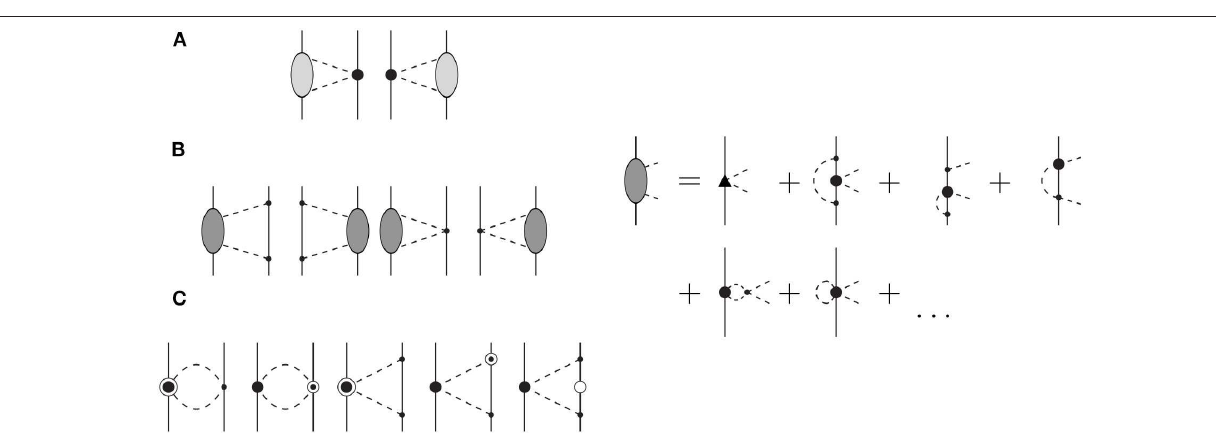
3. The subleading one-loop π N amplitude is represented by a =